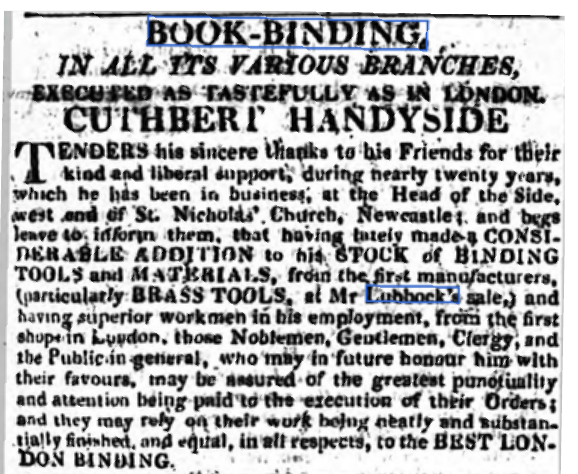
Fig. 47. Tyne Mercury; Northumberland and Durham and Cumberland Gazette (Tuesday 30 July 1822), p. 1. British Library Newspaper Archive.